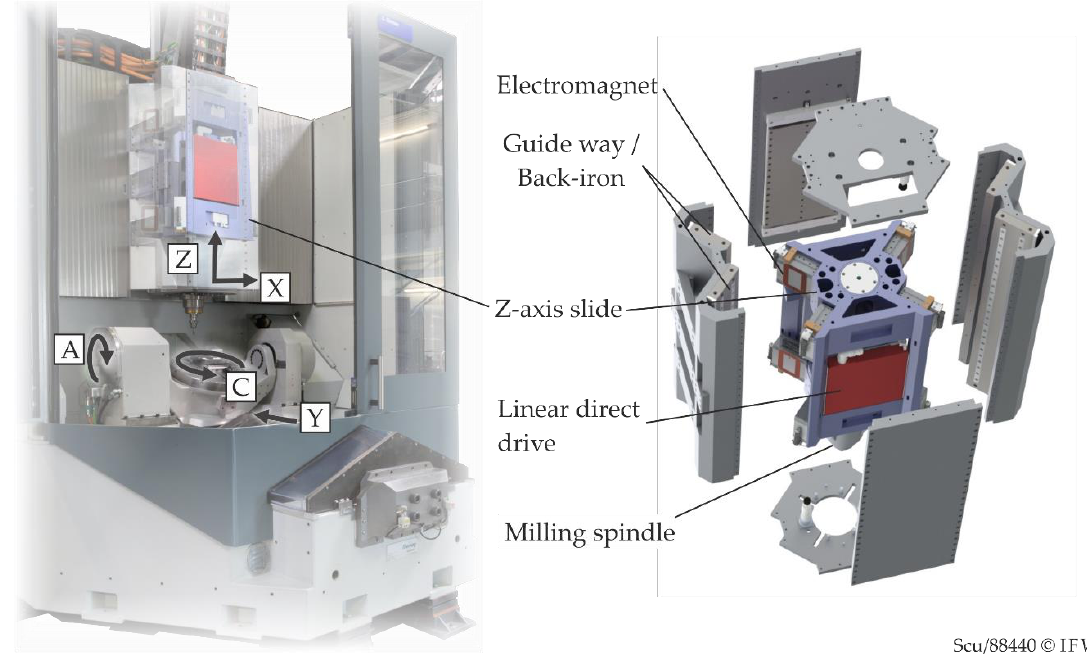
Figure 1. Milling machine prototype “Neximo” with elctromagentic guide in the Z-axis. On the tool side, the machine kinematics consist of the X-axis, which carries the Z-axis slide and finally, the milling spindle. On the workpiece side, the Y-axis carries a rotary swivel table with the A- and C-axes. All translational axes are driven by direct linear drives, the two rotational axes accordingly by torque motors. A unique technical feature is the Z-axis, which is guided electro-magnetically by eight electromagnets in an O-arrangement. These generate a maximum pulling force of 15 kN each and are equipped with eddy current sensors to determine the distance (air gap) to the back-iron or the guide ways. The position and orientation of the slide are controlled in 5 degrees of freedom by a state-space controller. It is implemented in a Soft PLC (Programmable Logic Controller) on an industrial PC (IPC) from BECKHOFF, running the TwinCAT real-time control environment. The Z-position of the slide, as well as all other NC axes, are controlled by a SIEMENS 840 d sl NC control. Communication between both control environments is established via a field bus connection (Figure 2a). This way, position and state data or setpoints can be exchanged in real-time. However, the sampling rate is limited to the interpolation cycle (IPO) of the NC control. In this case, the IPO amounts 8 ms.